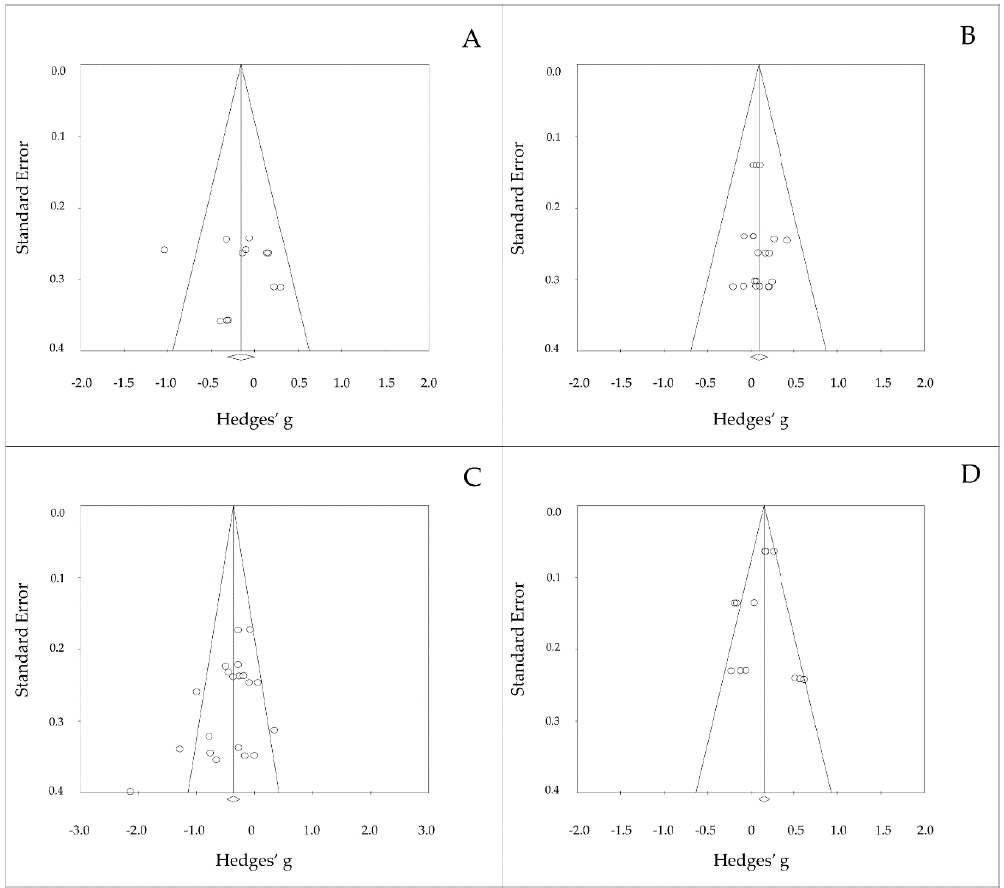
Figure 6. Funnel plotting of the results for short-term and long-term hearing changes to PTA or DPOAEs when using PLDs; ( A) PTA in short-term effect, ( B ) DPOAEs in short-term effect, ( C) PTA in long-term effect, and ( D ) DPOAEs in long-term